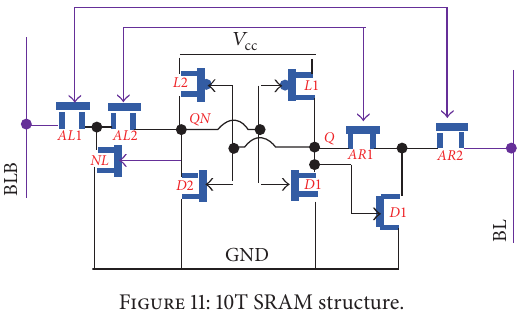
Figure 11: 10T SRAM structure. Table 3: Characteristics of CNTFET based SRAM [8].